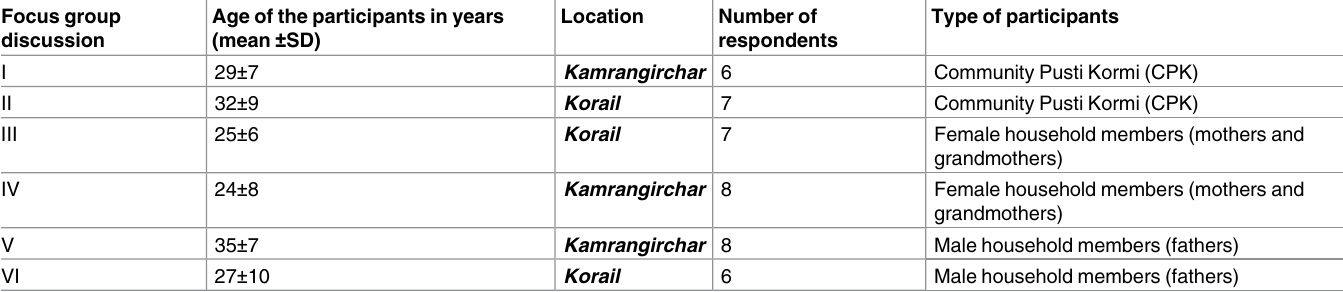
Table 3. Socio-demographic backgrounds of participants in focus group discussions. Focus group discussion